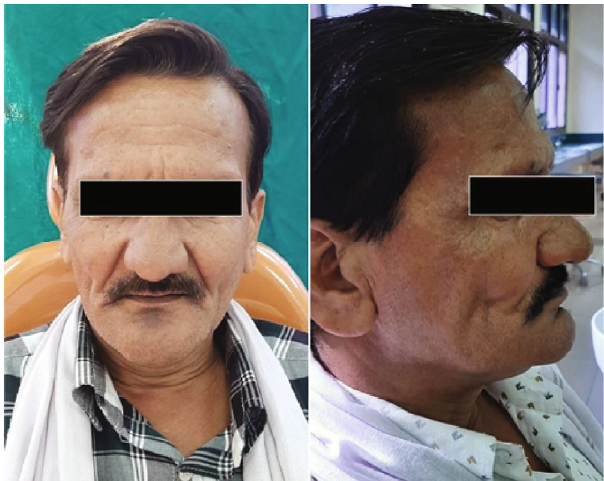
Figure 1: Straight pro fi le and side pro fi le of the edentulous patient showing sunken cheeks.